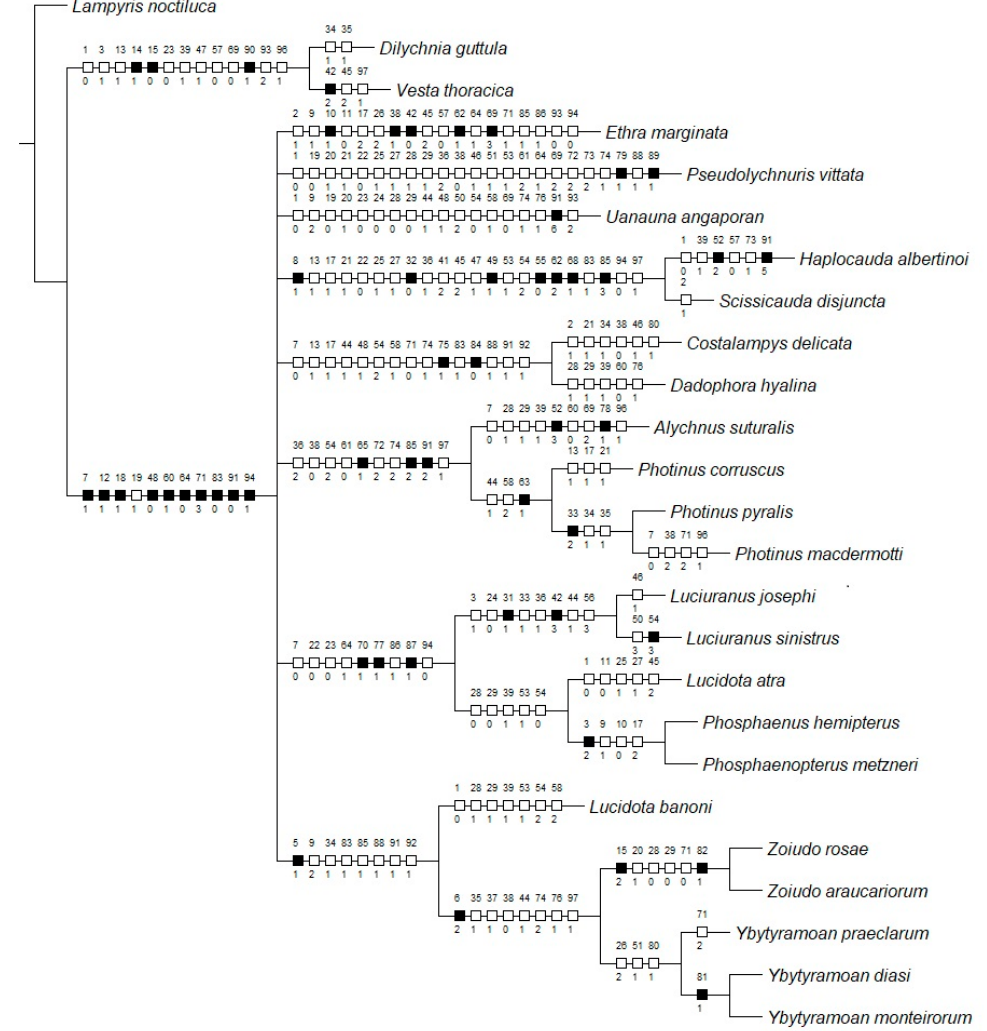
Figure 2. Maximum parsimony optimization of character state changes plotted on the majority rule Bayesian consensus tree. Black squares represent non-homoplastic synapomorphies. White squares represent homoplastic synapomorphies.